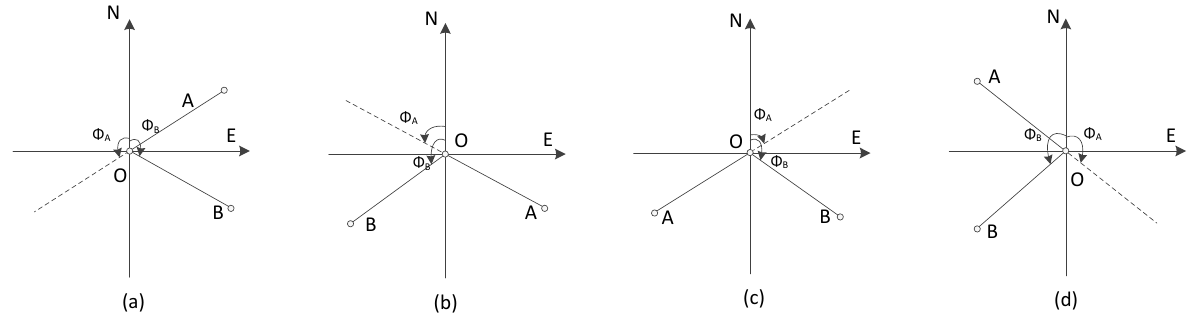
Figure 3. The turning model at road intersections.